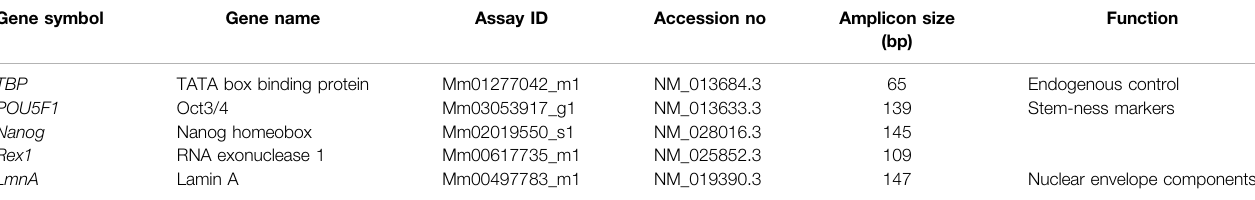
TABLE 2 | TaqMan gene expression assays used for